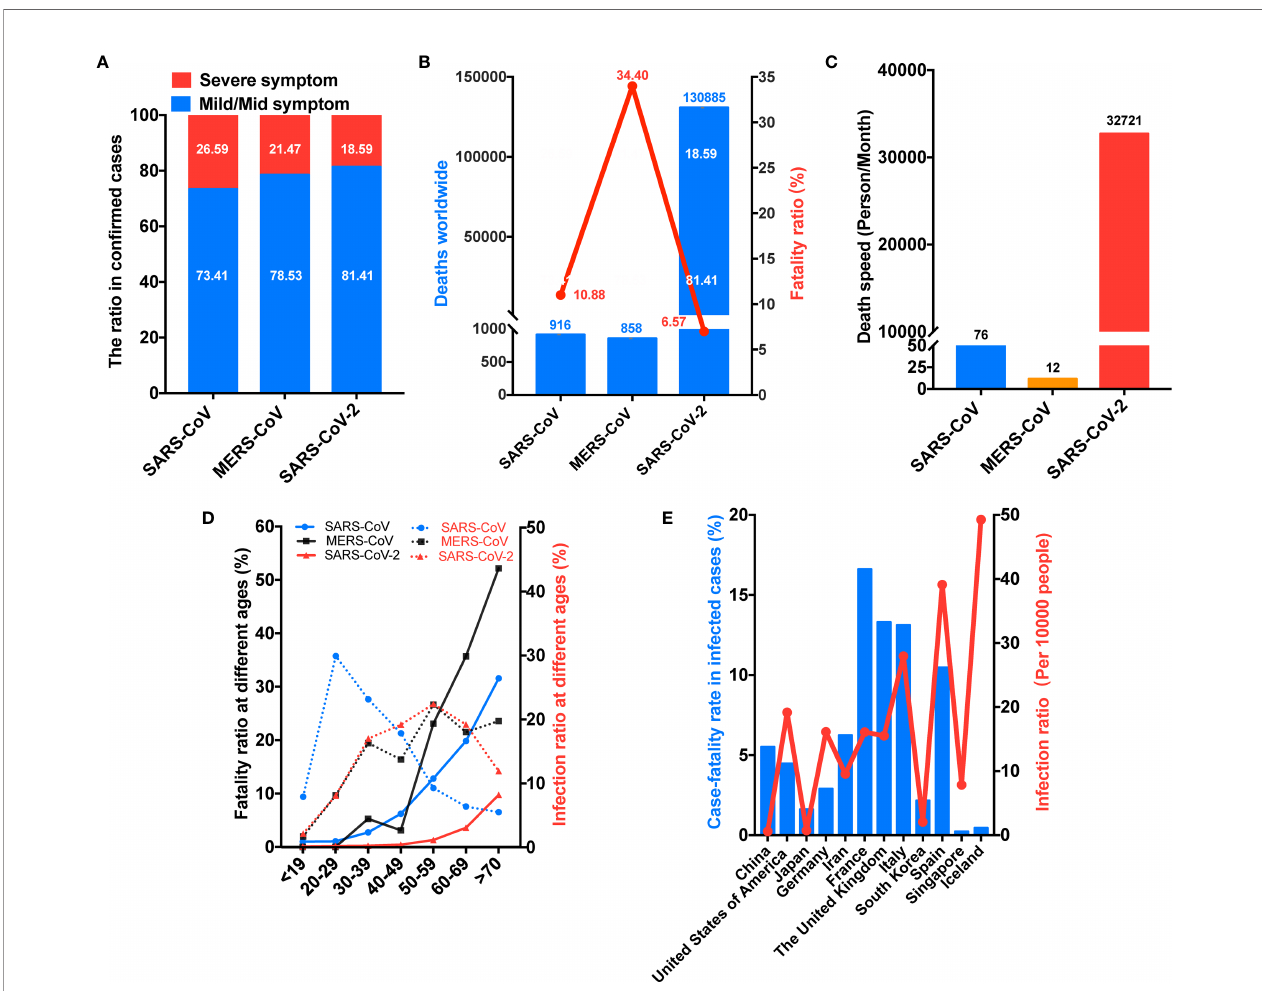
FIGURE 2 | COVID-19is leading tomoredeaths. (A) SARS-CoV-2 waslinkedtothehighestrateofmild-to-moderate pneumonia. (B) SARS-CoV-2hascausedthehighest numberofdeathsdespitehaving thelowestmortalityrate. (C) SARS-CoV-2causedthe highestnumber ofdeathsper month. (D) SARS-CoV-2mainlyinfectedmiddle-agedand elderlypeople,but theage-relatedincreaseinmortalitywasdelayed. (E) TheinfectionandmortalityratesofSARS-CoV-2 variedbycountry.SARS-CoV, Severe acuterespiratory syndromecoronavirus; MERS-CoV,Middle Eastrespiratorysyndromecoronavirus.SARS-CoV-2, Severeacuterespiratorysyndromecoronavirus